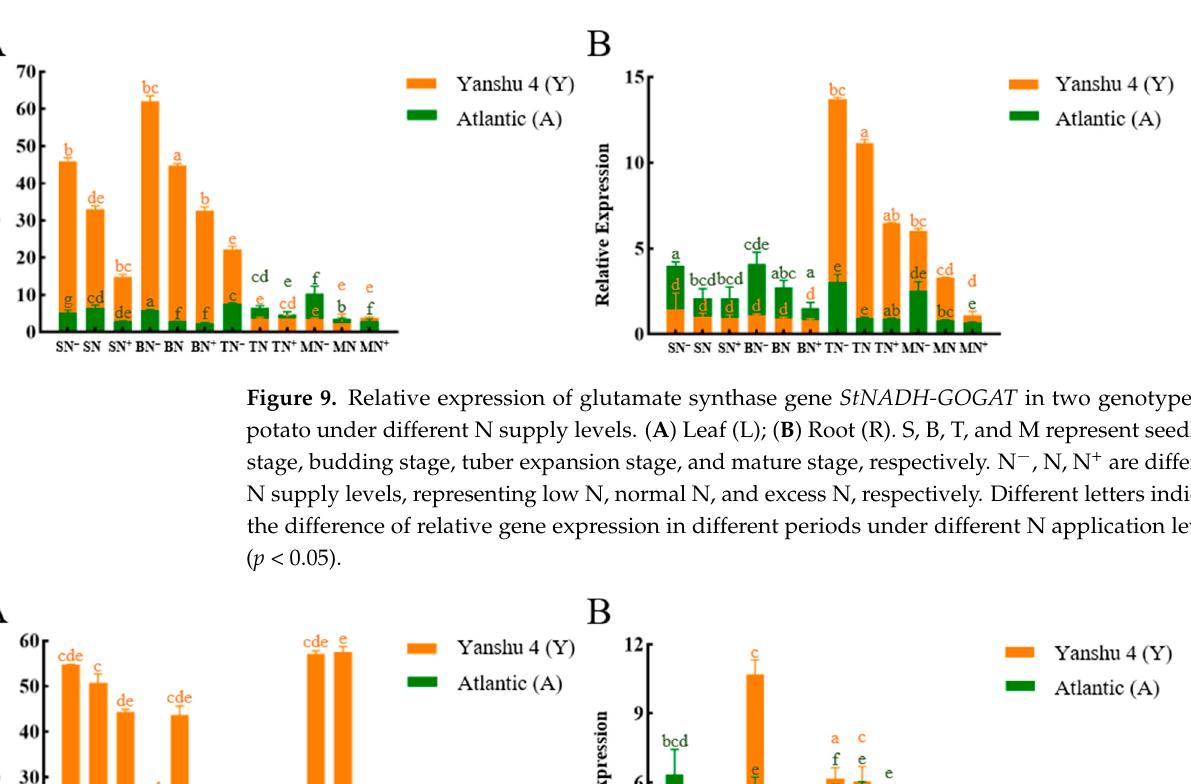
Figure 9. Relative expression of glutamate synthase gene StNADH-GOGAT in two genotypes of po- tato under different N supply levels. ( A ) Leaf (L); ( B ) Root (R). S, B, T, and M represent seedling stage, budding stage, tuber expansion stage, and mature stage, respectively. N − , N, N + are different N supply levels, representing low N, normal N, and excess N, respectively. Different letters indicate the difference of relative gene expression in different periods under different N application levels ( p < 0.05).